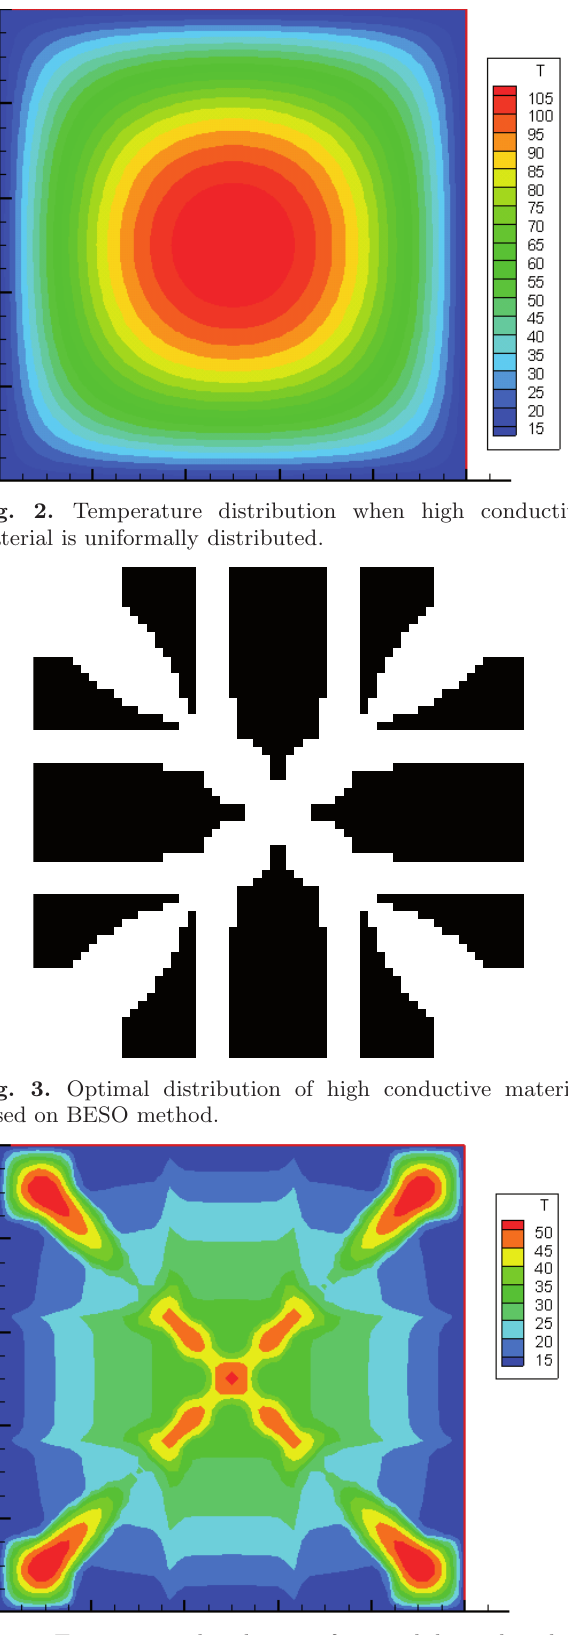
Fig. 4. Temperature distribution of optimal design based on BESO method.